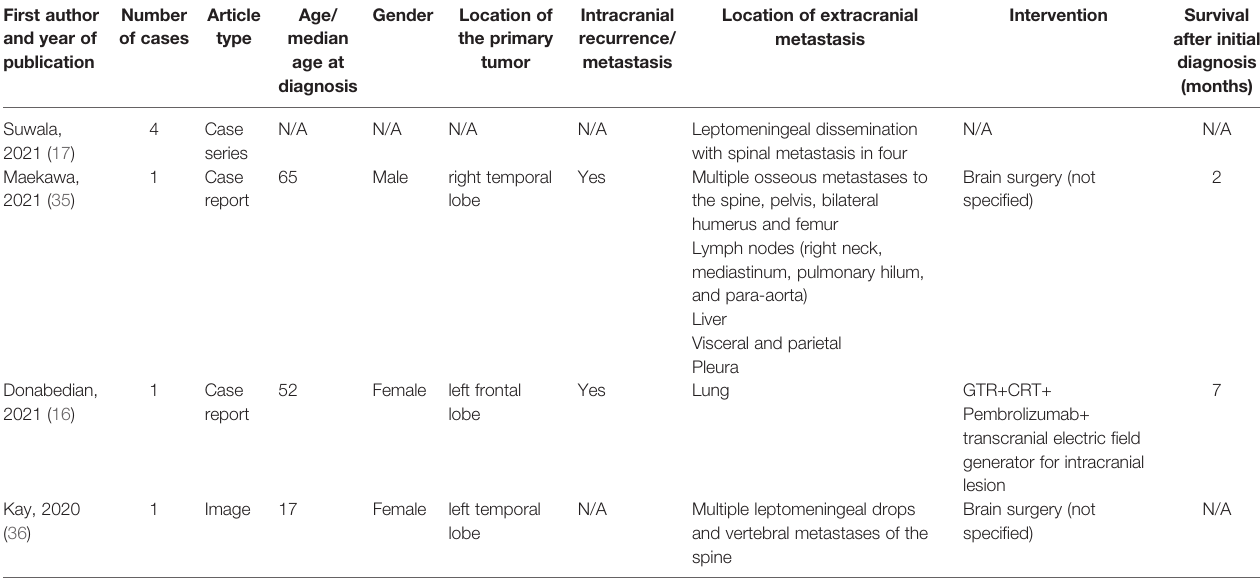
TABLE 2 | Reported cases of extracranial metastasis of glioblastoma multiforme with primitive neuronal